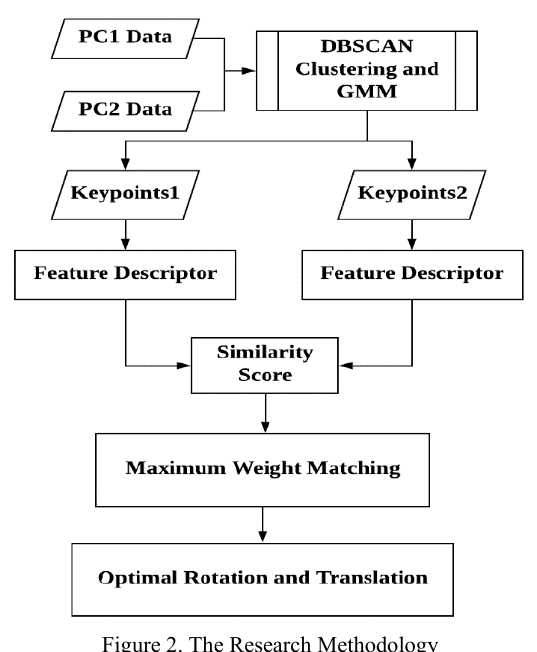
Figure 2. The Research